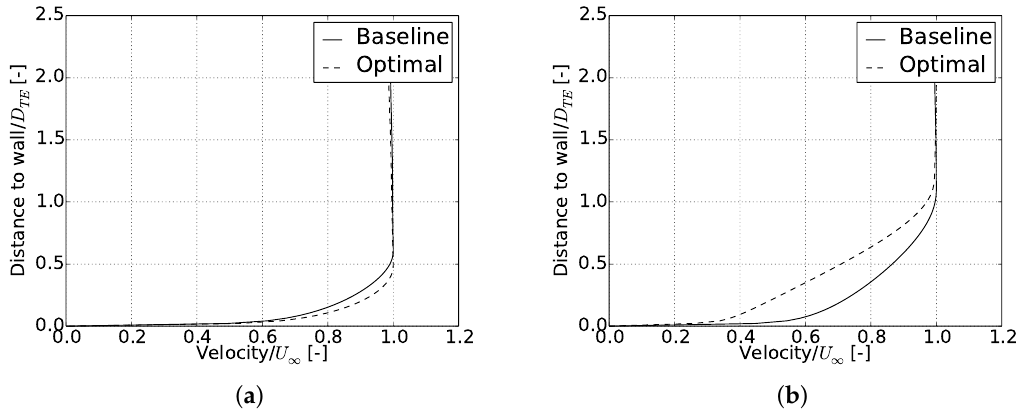
Figure 6. Boundary layer profiles on the suction side. ( a ) Suction side at peak Mach number location; ( b ) Suction side close to the trailing edge (TE). Table 1. Boundary layer